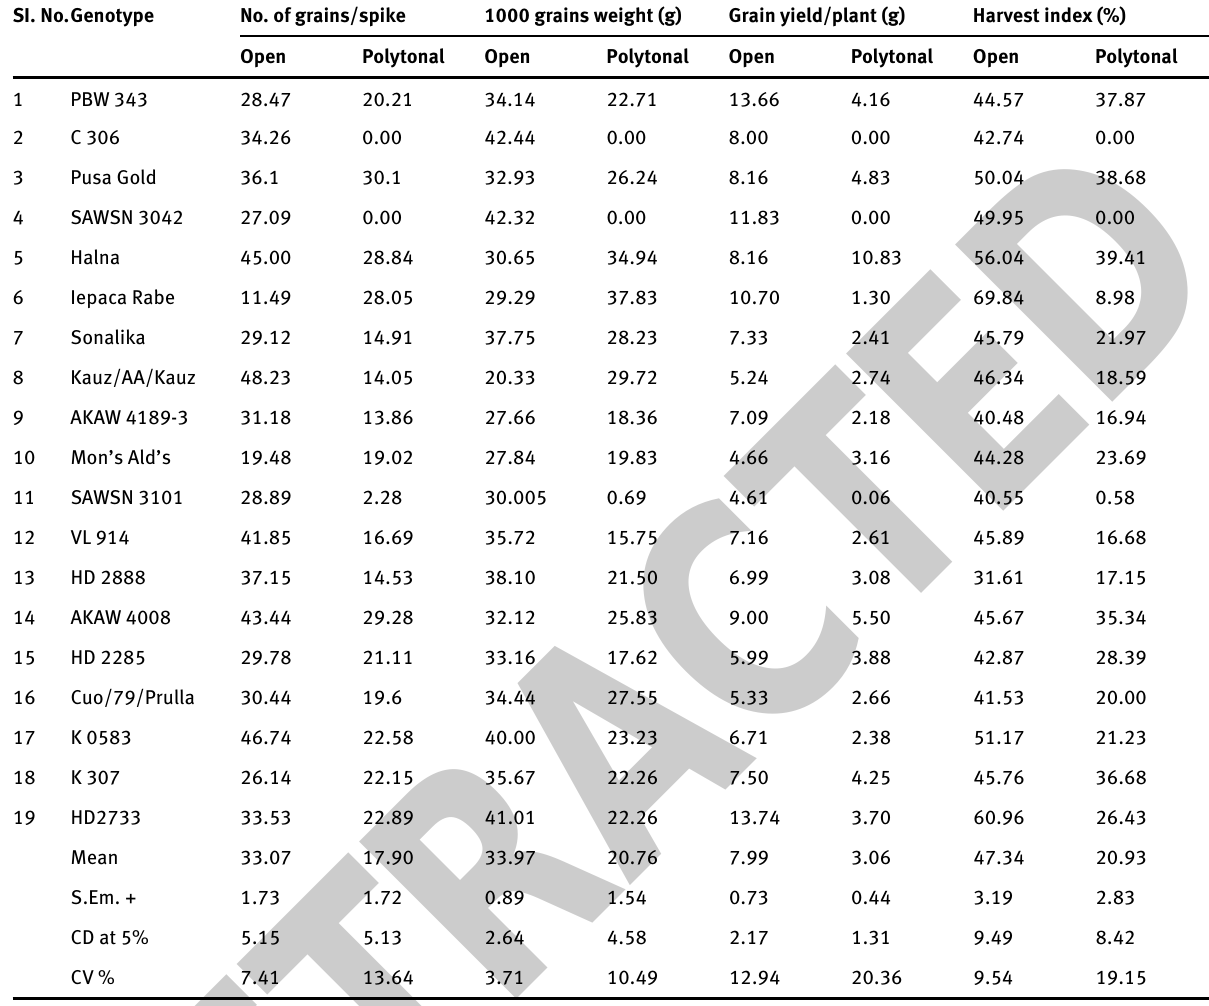
Table 3: Average days to no. of grains/spike, 1000 grains weight, Grain yield/plant, Harvest index of 19 genotypes of wheat in open and polytonal conditions SI.